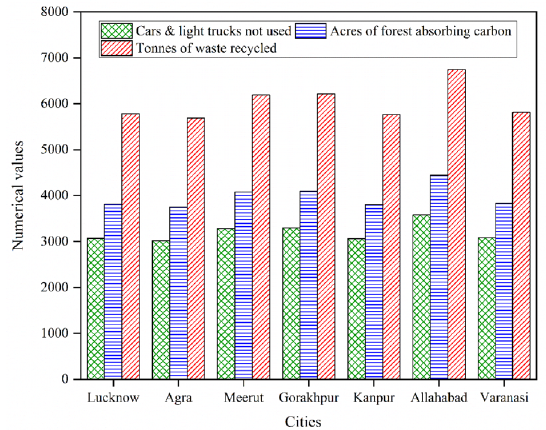
Figure 14. Equivalence of gross annual GHG emission reduction of all